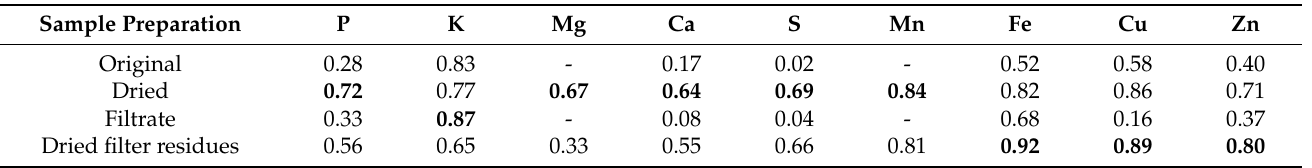
Table 2. Coefficients of determination (R 2 ) from linear regression between XRF and reference concentrations determined by the standard lab procedure (best values in bold letters) 1 .